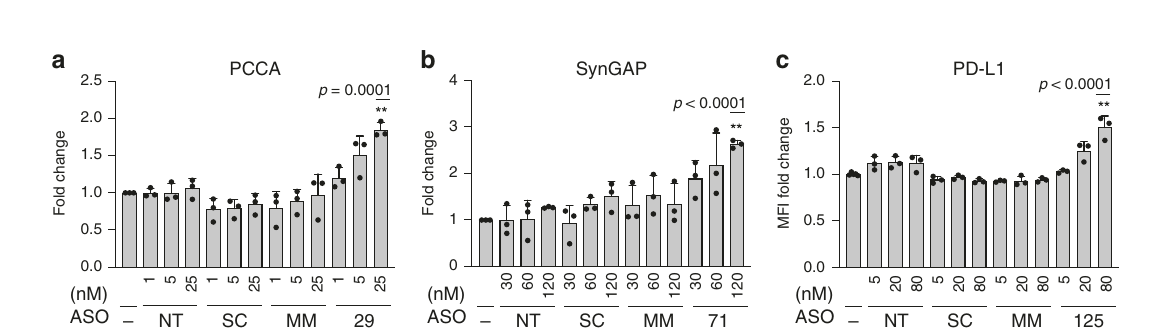
Fig. 4 ASOs dose-dependently reduce NMD and increase mRNA in vitro. a RT-PCR (left panel) and qPCR (right panel) of a selected PCCA ASO (ASO- 29) targeting the exon inclusion event transfected in HEK293 cells at increasing concentrations for 24 h. Exact p -values for bars with asterisks are 0.0008 and 0.0001, respectively. b RT-PCR (left panel) and qPCR (right panel) of a selected SYNGAP1 ASO (ASO-71) targeting the alternative 3 ′ ss transfected in HEK293 cells at increasing concentrations for 24 h. Exact p -values for bars with asterisks are 0.0001 and 0.0003, 6.99e-5 and 4.25e-5, respectively. c RT-PCR (left panel) and qPCR (right panel) of a selected CD274 ASO (ASO-125) targeting the alternative intron transfected in Huh7 cells at increasing concentrations for 24 h. Cell were treated with 50 μ g/mL of CHX for 3 h prior to harvesting to visualize and quantify the non-productive mRNA. Exact p - values for bars with asterisks are 6.38e-6 and 9.21e-5, respectively. d RT-PCR (left panel) and qPCR (right panel) of two selected SCN1A ASOs (ASO-135 and ASO-136) targeting the exon inclusion event delivered by free uptake into ReNCell VM cells at increasing concentrations for 72 h. RT-PCR results (bar graphs on the left) show dose-dependent reductions of the non-productive mRNA and qPCR results (bar graphs on the right) show dose-dependent increases of productive mRNA. Exact p-values for bars with asterisks are 1.69e-10, 2.50e-11, and 1.49e-11; 2.91e-8, 2.05e-10, and 2.59e-11; 4.21e-7, 1.10e-8, and 1.35e-10; and 7.26e-5, 4.01e-8, and 9.08e-12, respectively. No-ASO ( − ), scramble (SC), and mismatch (MM) controls were included in each experiment at the same increasing concentrations as the respective targeting ASOs. All experiments were performed in three biological replicates. Data are presented as mean values ±SD. P -values were calculated using two-sided t -test. Asterisks denote ASOs that are statistically signi fi cant ( p < 0.001) in both RT-PCR and qPCR analyses. Red and gray rectangles denote NMD-inducing event and protein-coding exons, respectively. Source data are provided as a Source Data fi le.